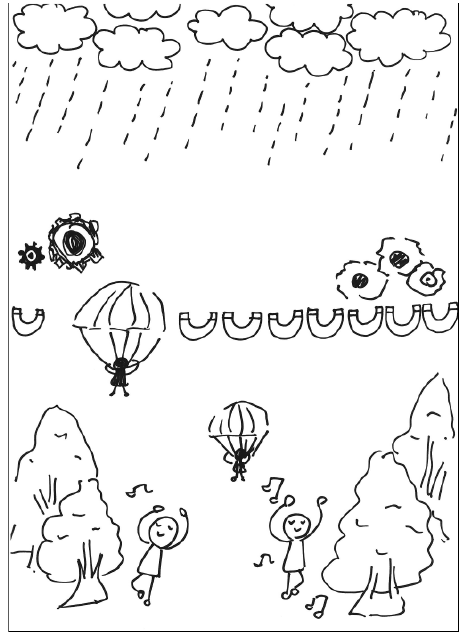
Figure 10. Work by D4 Severe Depression.